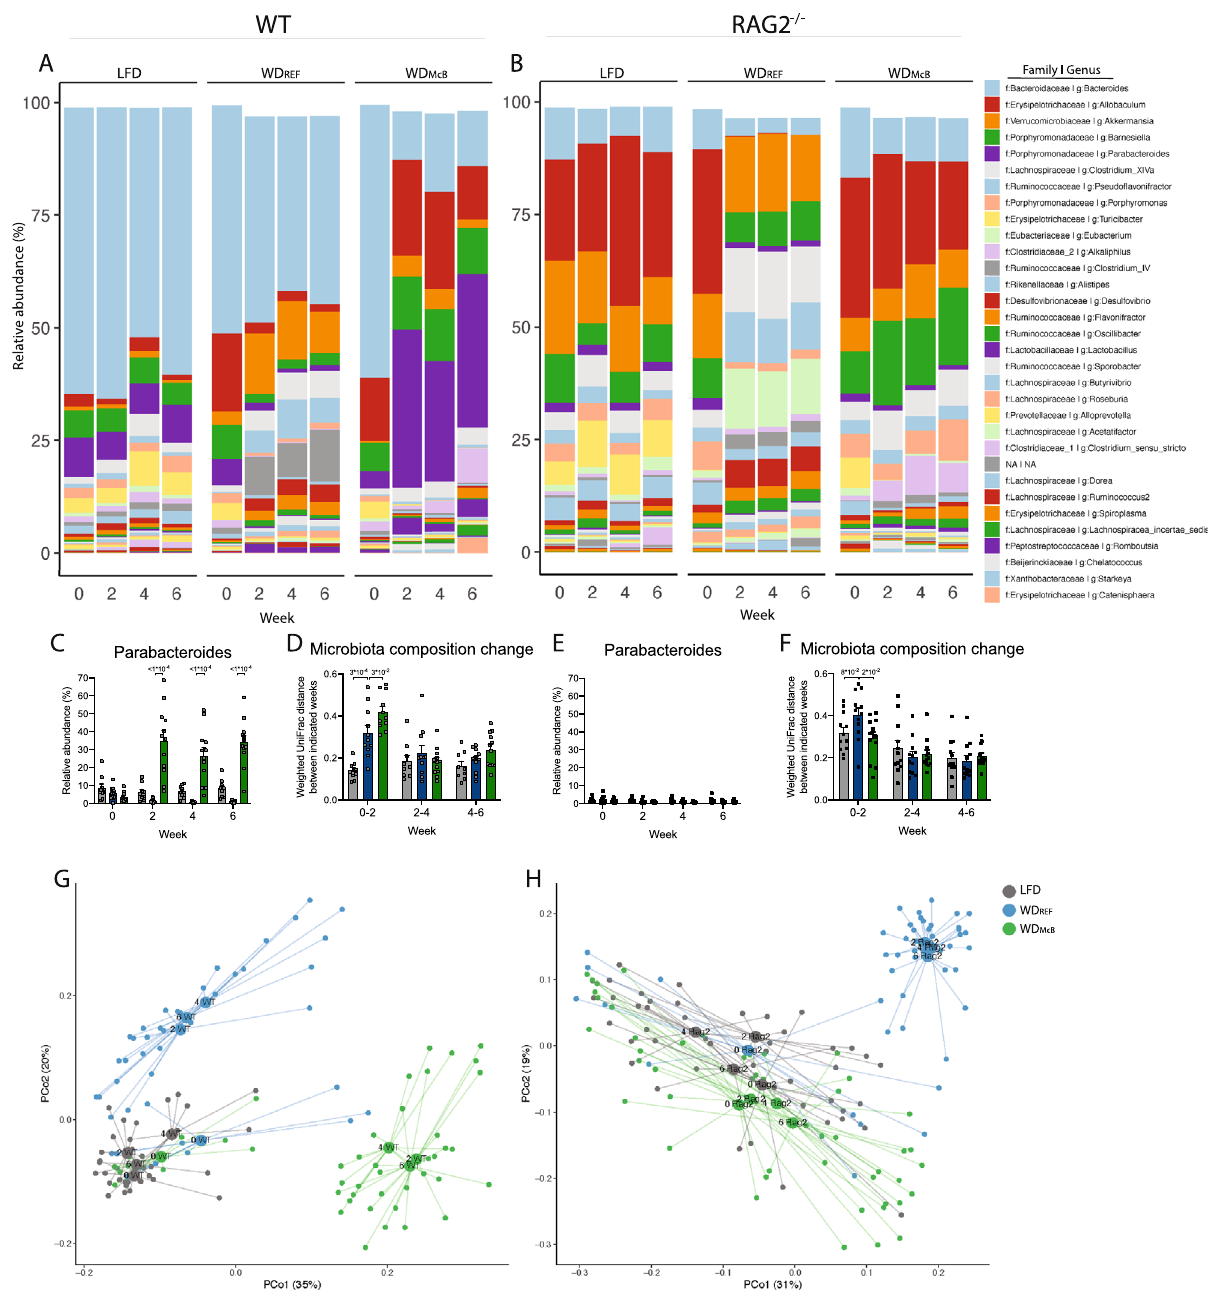
Fig. 7 McB lysates rely on adaptive immunity to boost Parabacteroides . A, B Taxasummary of most abundant bacterial genera showing mean relative abundance of indicated genera in each group at indicated timepoint in WT ( A ) and RAG2 − / − ( B ) mice. C , E Relative abundance of Parabacteroides in fecal samples of indicated genotype at indicated timepoint. D, F Weighted UniFrac distance (instability test) between paired samples from indicated 2-weeks interval post dietary intervention in WT (D) and RAG2 − / − (F) mice. C – F Bars represent group mean ± SEM and dots indicate individual data points. All fi cance compared to WD p -values < 1 × 10 − 1 between WD REF and indicated group are depicted. Statistical signi REF by two-way ANOVA-RM, adjusted for multiple comparisons by Dunnett post-hoc. G, H PCoA of fecal microbiota composition of indicated group at baseline (Week 0, all mice fed LFD) and after 2, 4, and 6 weeks of dietary intervention with group mean indicated as